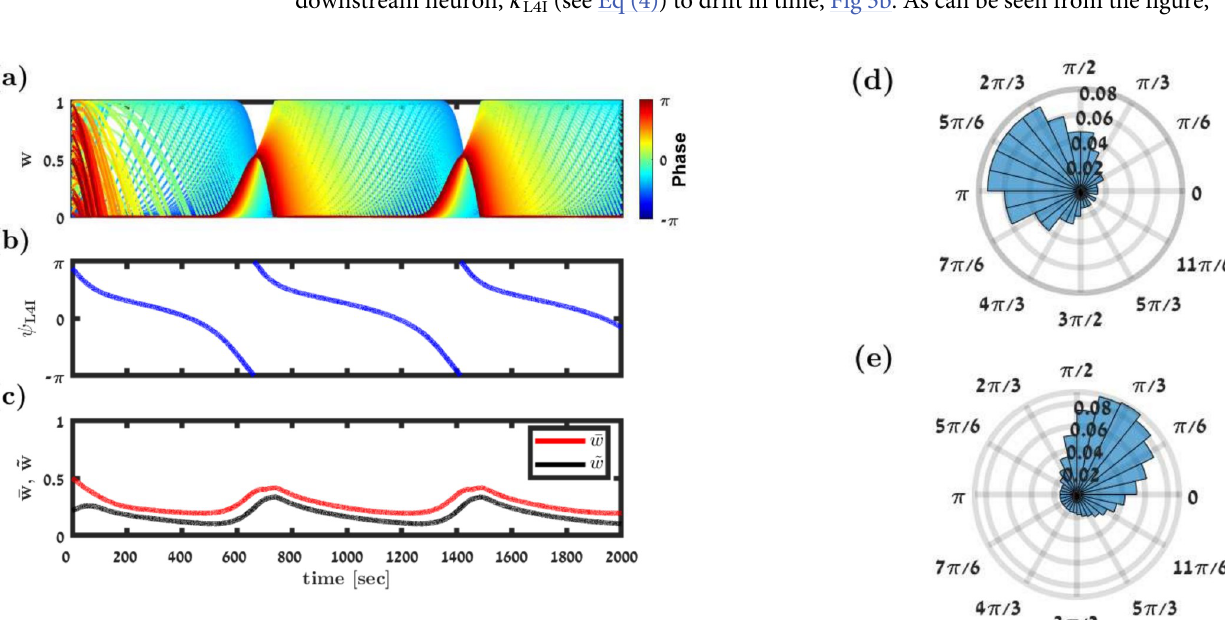
PLOS Computational Biology | https://doi.org/10.1371/journal.pcbi.1009353 September 17,